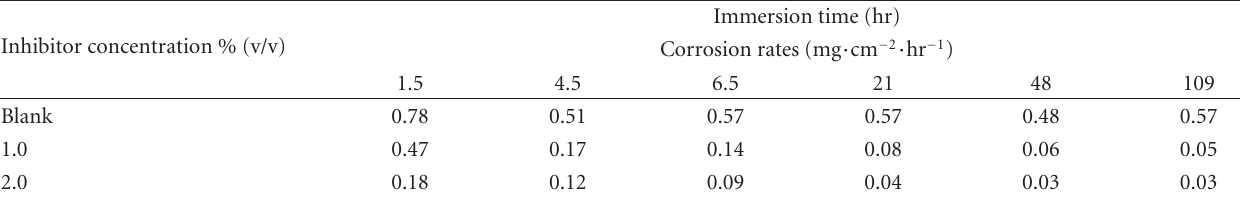
Table 1: Corrosion rates as a function of immersion time with and without Pachycormus discolor ethanol extract . Inhibitor concentration % (v/v)